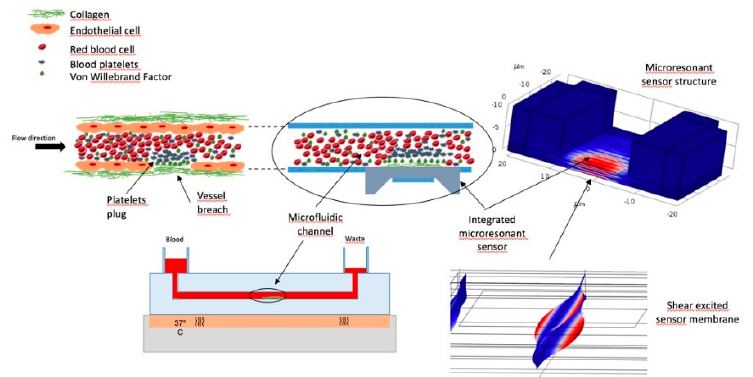
Figure 1. Schematic representation of the sensor platform for the analysis of primary haemostasis integrating the microfluidic system mimicking the rheological blood flow conditions, functionalized interface for the localized platelets binding, integrated microacoustic sensor, flow rate and pressure control system. Displacement field distribution of microresonant structure was obtained using COMSOL Multiphysics ®